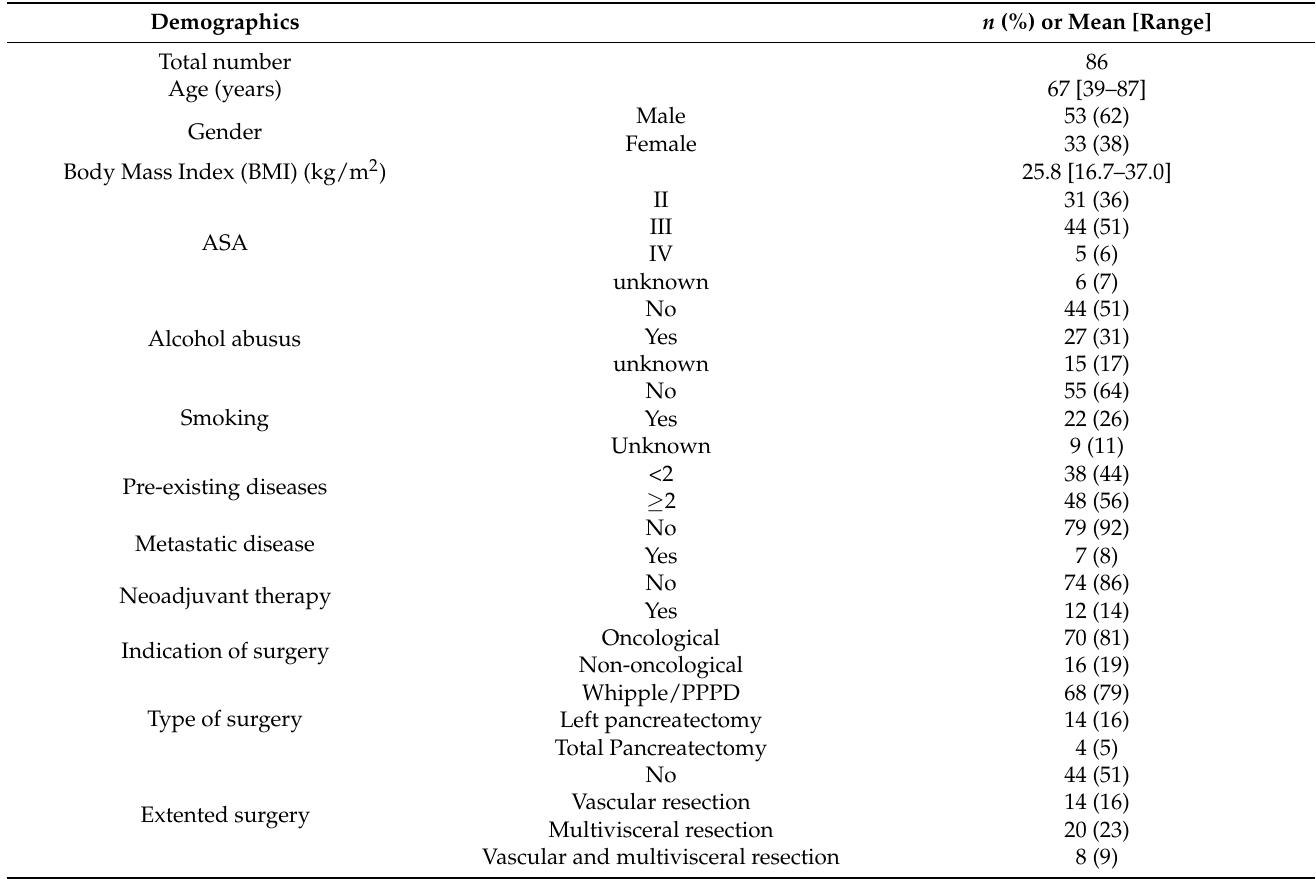
Table 1. Demographics and characteristics of patients with in-hospital mortality after pancreatic surgery.